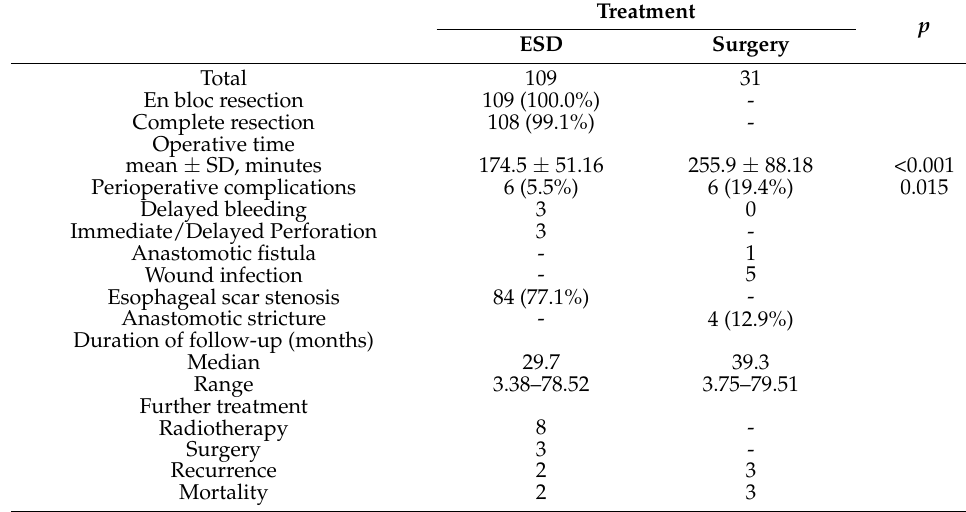
Table 4. Clinical outcomes of ESD and